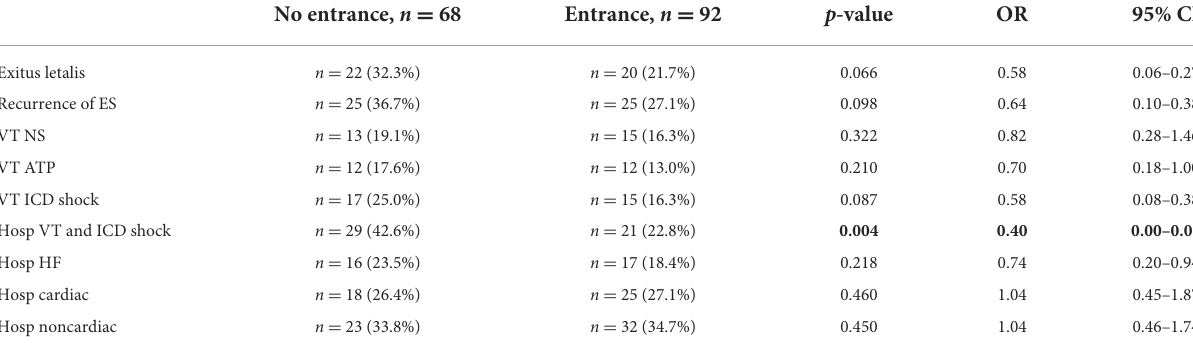
TABLE 11 Analysis between no entrance vs. present of entrance and